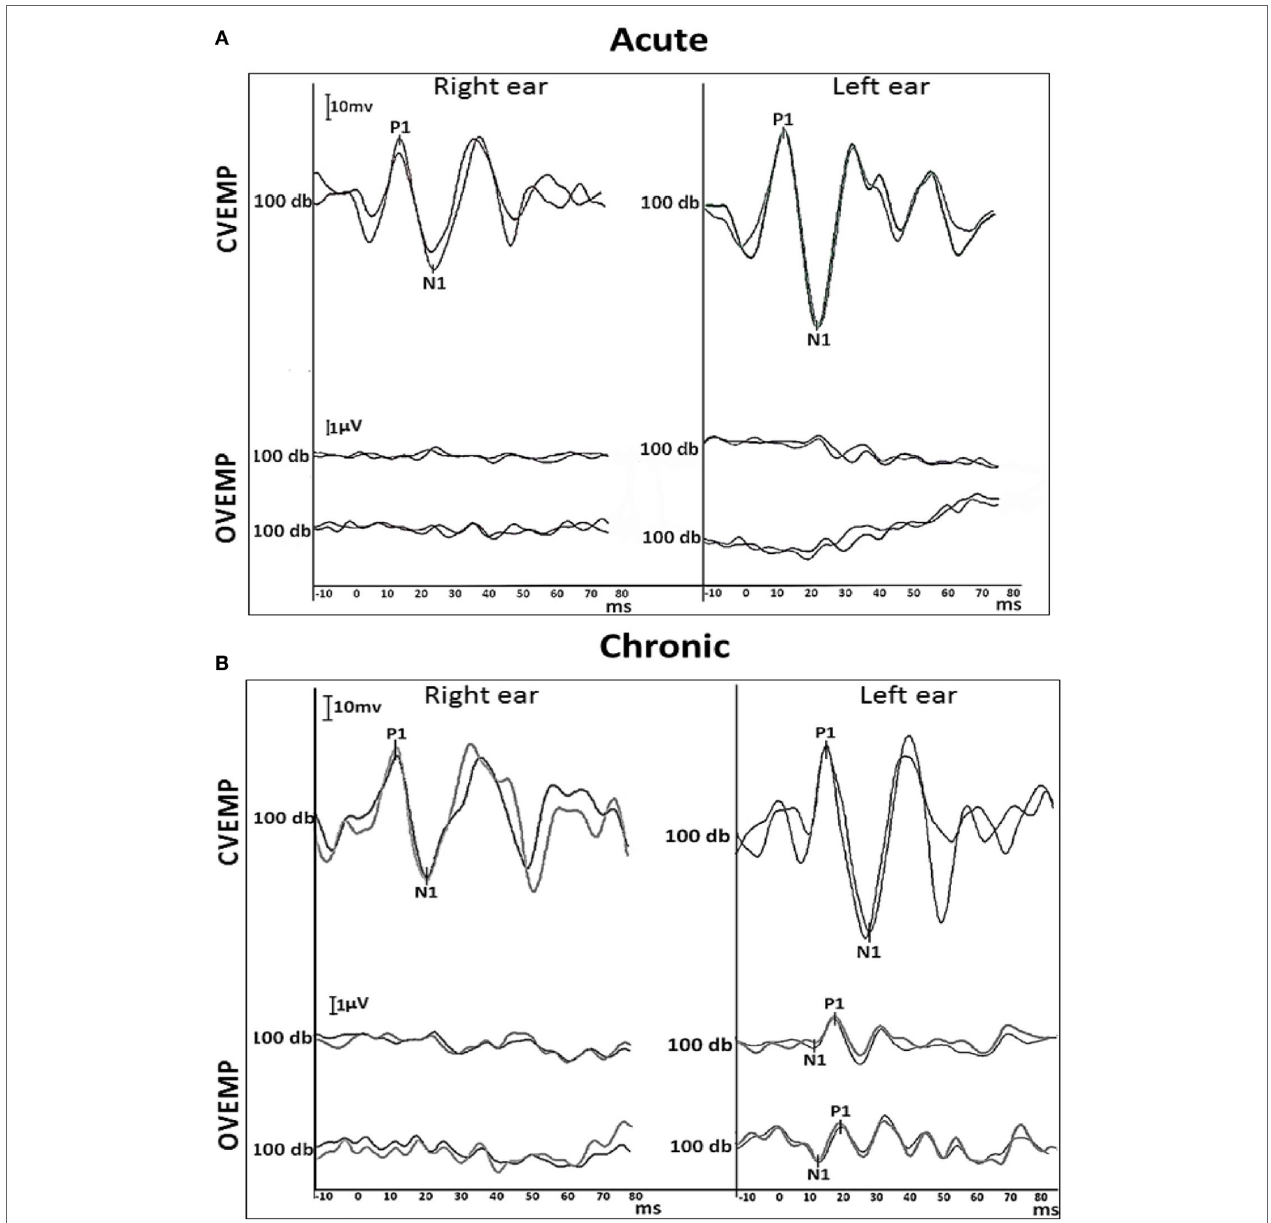
FIgURe 3 | Air-conducted VEMP traces. (a) Acute cervical (top) and ocular (bottom) VEMP responses recorded 2 weeks from the onset of symptoms. (B) Chronic cervical (top) and ocular (bottom) VEMP recorded again at 12 months. The cVEMP responses were reproduced bilaterally at the acute and chronic stages with latency, amplitude and asymmetry within the normal range. The cVEMP amplitudes [normalized to background electromyography (EMG) activation (EMG scaling)], showed < 20% asymmetry, suggesting bilaterally spared inferior vestibular nerves. In contrast, the acute oVEMP showed no reproducible responses bilaterally. At 1 year, a reproducible oVEMP was observed only on the left side. Two trials were conducted in order to confirm results (two traces). Cervical and ocular VEMP waves of respective potentials (positive and negative deflections—P1/N1) were analyzed. Stimuli was a 100 db air-conducted 500 Hz tone